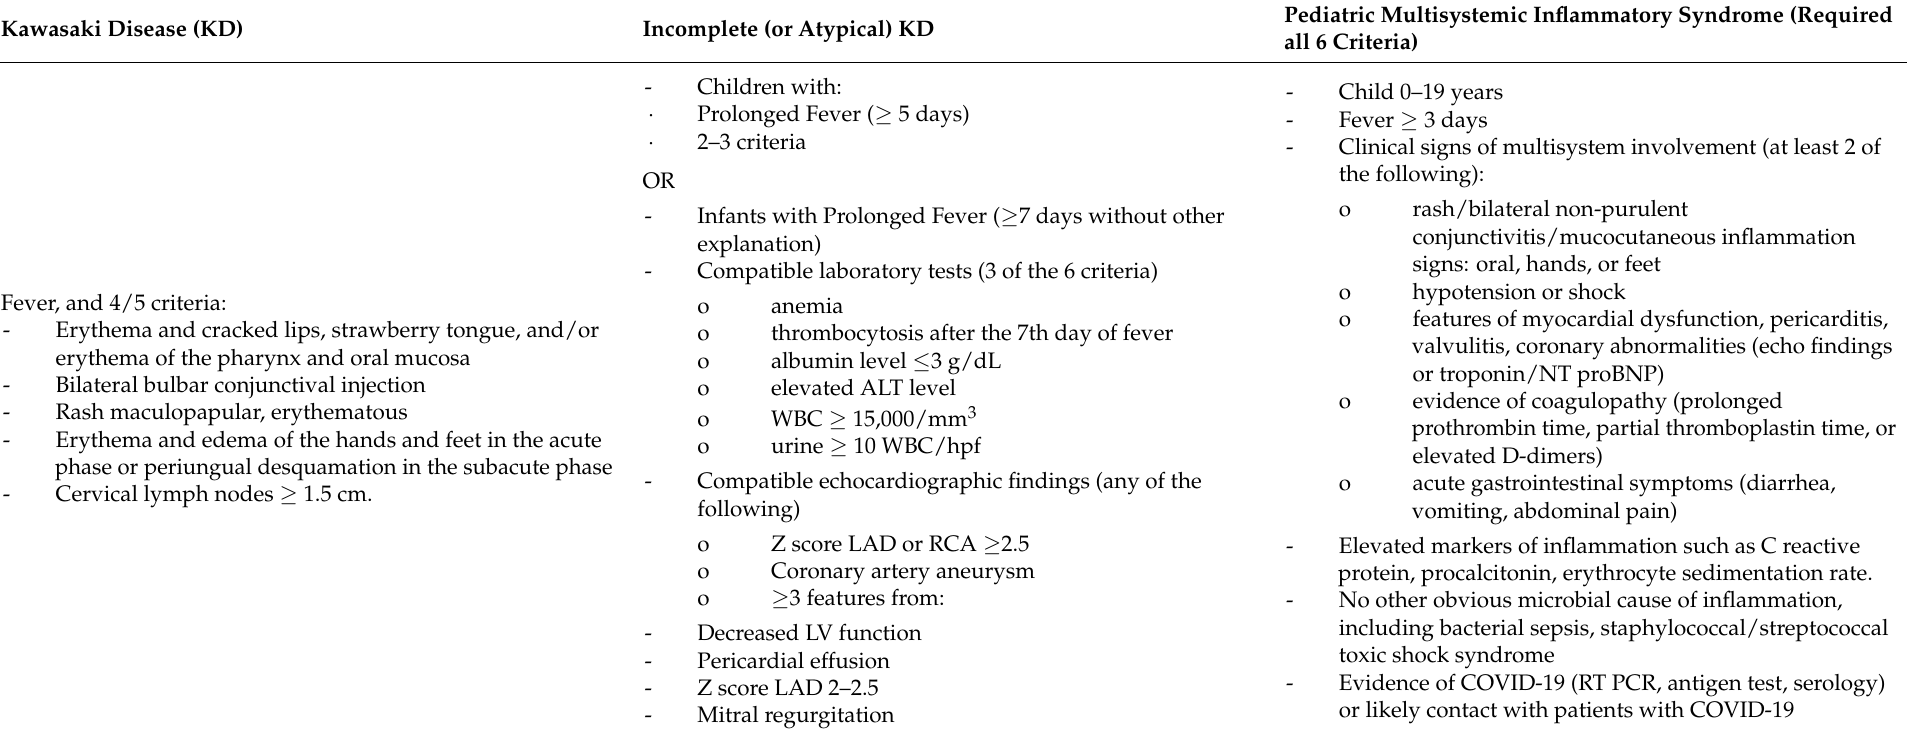
Table 1. Comparative view of the diagnostic criteria of Kawasaki disease, incomplete or atypical Kawasaki disease, and pediatric multisystemic inflammatory syndrome, with permission from Voicu et al. [9–11]. COVID-19: coronavirus 2019 disease; LAD: left anterior descending; NTproBNP: N-terminal pro Brain